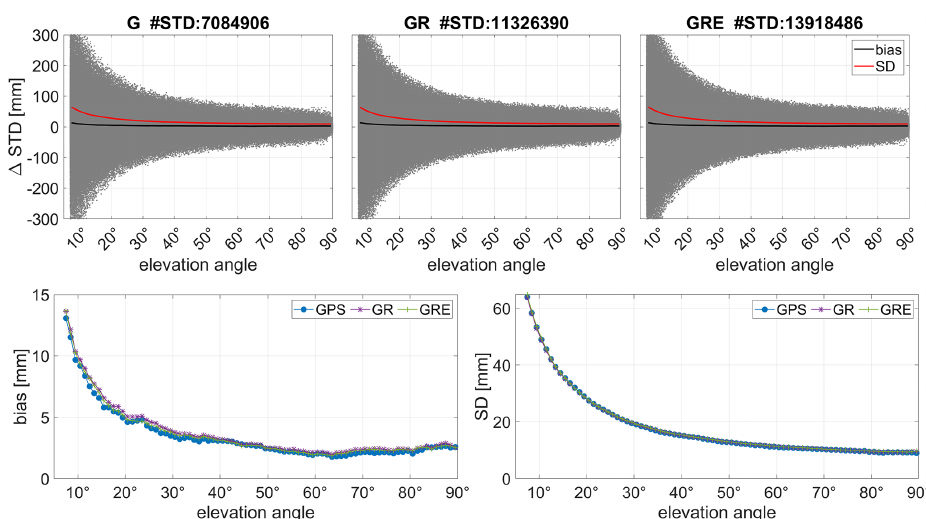
Figure 14. The STD differences between ERA5 and three GNSS solutions for the year 2020 for all 663 stations with marked average biases and SDs (top) and the averaged biases and SDs from all solutions altogether